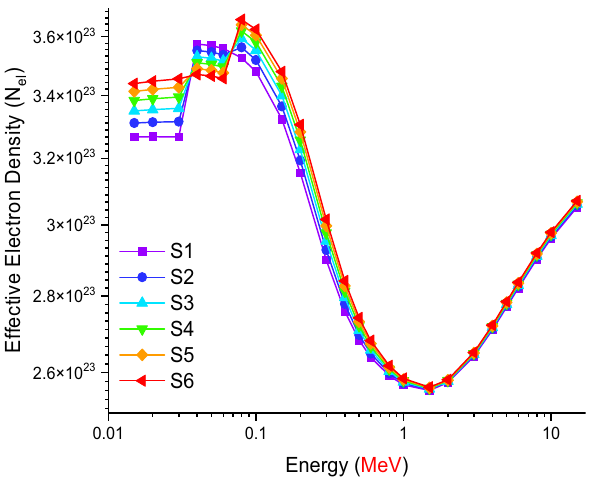
Figure 3: Variations of e ff ective electron density ( electrons/g ) with photon energy ( MeV ) for all S1 – S6 glasses.